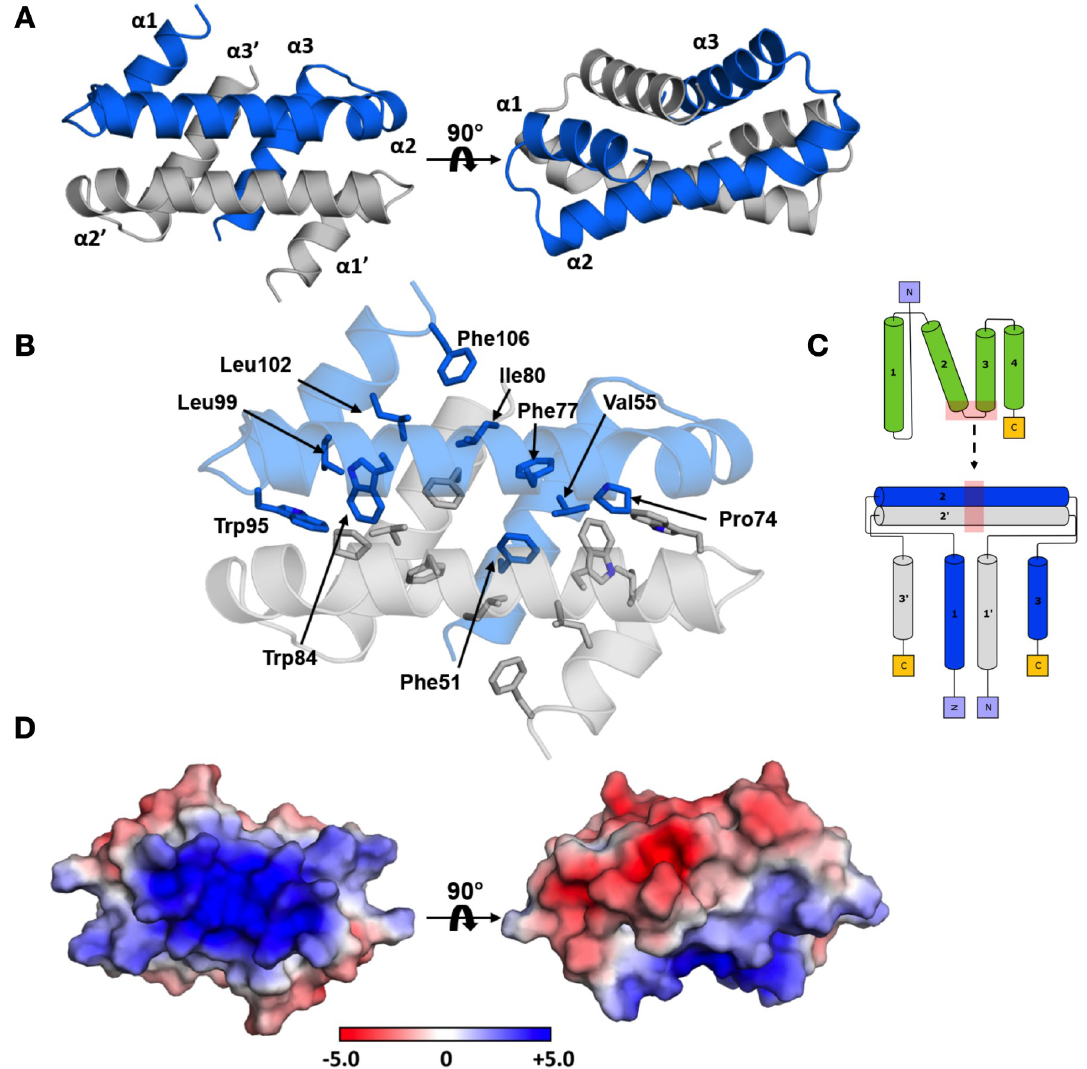
Fig 2. The crystal structure of dArc2-NL. (A) The domain-swapped dimer observed in the crystal, with the three α -helices labeled. (B) The folded dimer encapsulates an extensive hydrophobic core, with no polar interactions connecting the two monomers. Residues are only labelled in subunit A, but also seen in subunit B. (C) Topology diagram of domain swapping. The location of the conformational change is indicated by red shading. (D) The electrostatic surface of the dimer. The α 2 and α 2’ have a positive surface potential, in contrast to the surface formed by α 1, α 3, α 1’, and α 3’. The protein is in the same orientations as in